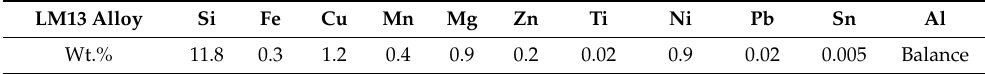
Table 1. Alloy in wt.%.